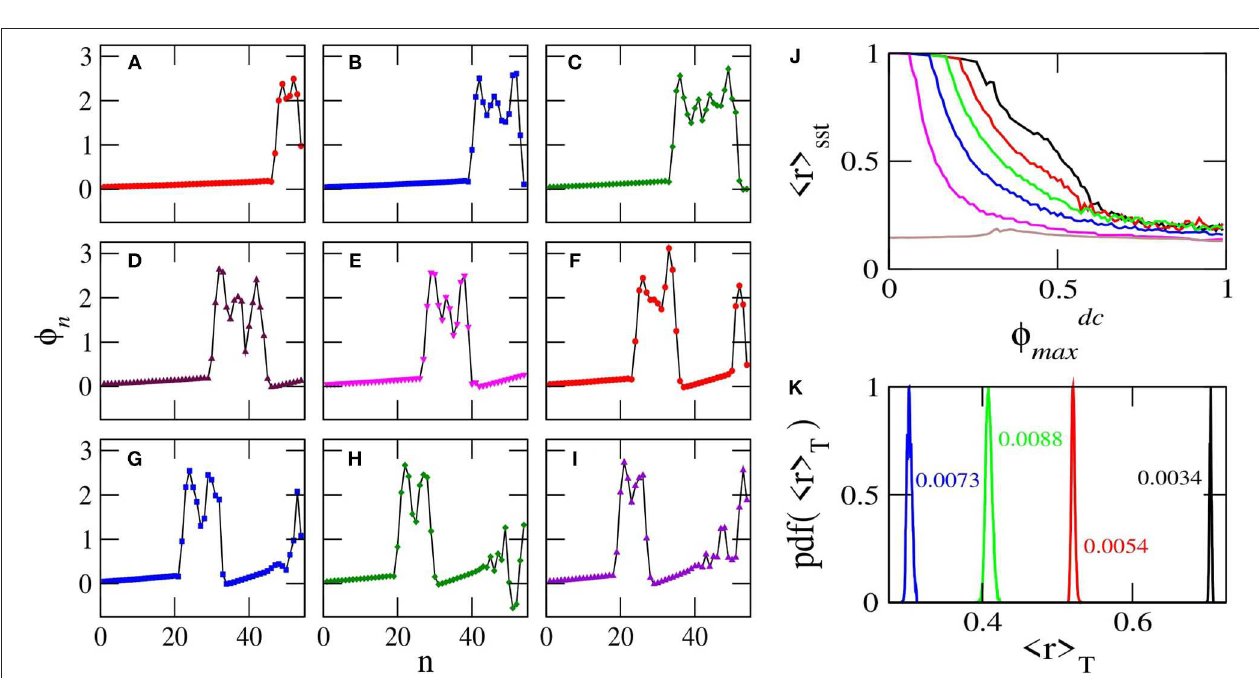
FIGURE 10 | Map of the magnitude of the synchronization parameter averaged over the steady-state integration time, φ ac ) parameter plane, for β L ( φ dc −